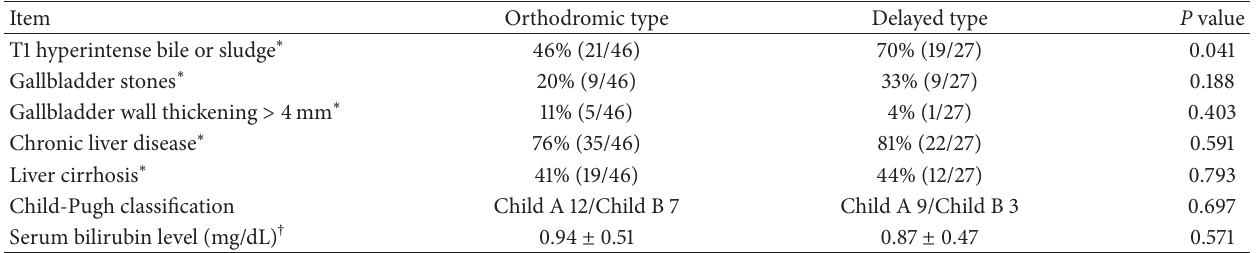
Table 1: Relationships between the type of accumulation of bile in gallbladder and each item of imaging findings and clinical